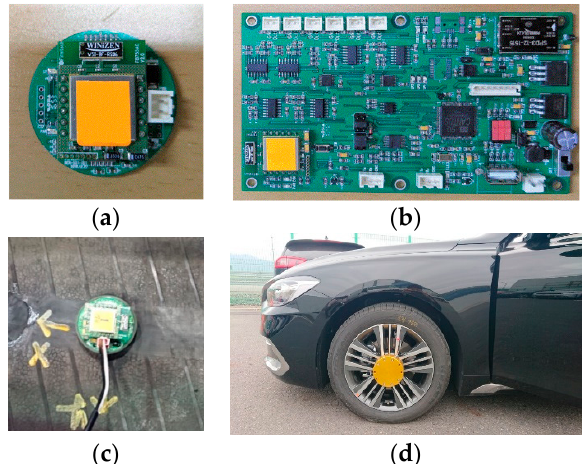
Figure 4. iTire system experimental setup: ( a ) sensor board, ( b ) classification module, ( c ) sensor board attached to the inside of a tire, and ( d ) battery module (at wheel center).